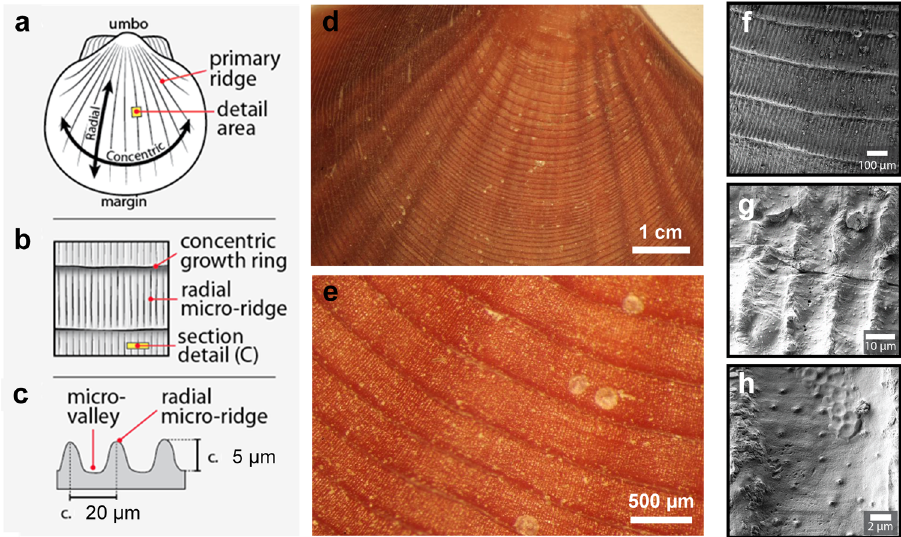
Fig. 3 Surface characteristics of the Antarctic scallop ’ s shell features. a – c Terminology and schematics of features on the shell surface, a , b in-plane, and c section view. d , e Macroscopic images in visible light of the Antarctic scallop ’ s shell surface without magni fi cation. The shell is covered by a thin, proteinaceous covering (periostracum), under which the calcitic material lies throughout the thickness of the shell. Radial rounded, primary ridges, and concentric growth rings are visible. f – h Scanning electron micrographs showing increasing magni fi cation. f Concentric growth rings separating repeating series of g radial micro-ridges (c. 20 µ m peak-to-peak). h Small protuberances are irregularly dispersed throughout the radial micro-valleys (Supplementary Fig. 3). Shells are oriented with the umbo at the top in all panels, except c . Shells of temperate control species are substantially rougher and less ordered than those of the Antarctic scallop (Supplementary Fig.